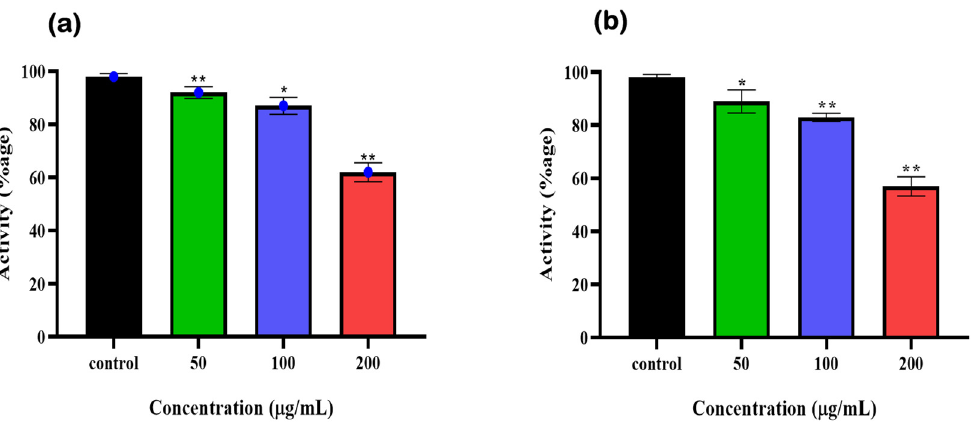
Figure 10. 6-PGD enzyme activity purified from fresh A549 cells post treatment of ( a ) syringaresinol and ( b ) cleomiscosin A at various concentrations (50, 100 and 200 µ g/mL), whereas * p < 0.005 and ** p < 0.001.